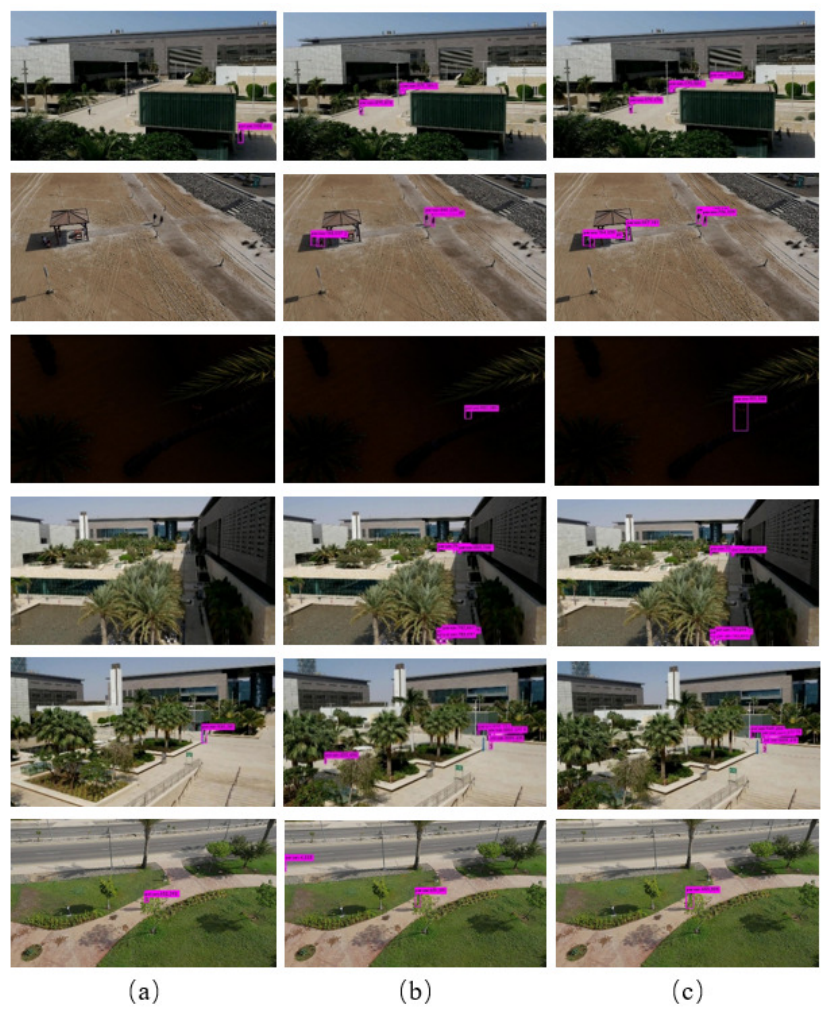
Figure 5. Detected results of different methods on UAV-viewed dataset. ( a ) Detected results of original YOLOv3; ( b ) detected results of YOLOv3 using optimized training method; ( c ) detected results of